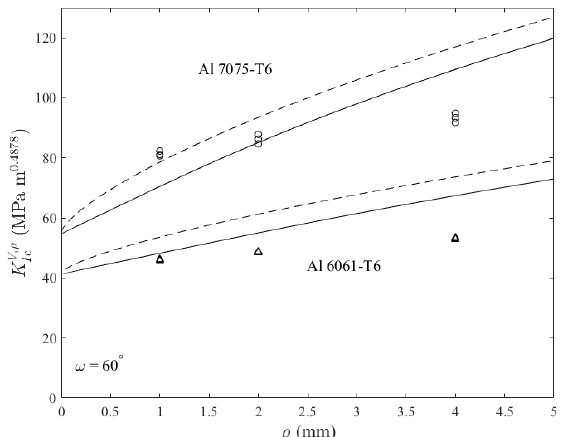
Figure 3. Blunt V-notched structures ( ω = 30 ◦ ), apparent generalized fracture toughness: Predictions by punctual FFM (dashed line) and average FFM (continuous line) related to experimental data on Al 7075-T6 plates (circles) and on Al 6061-T6 plates (triangles).